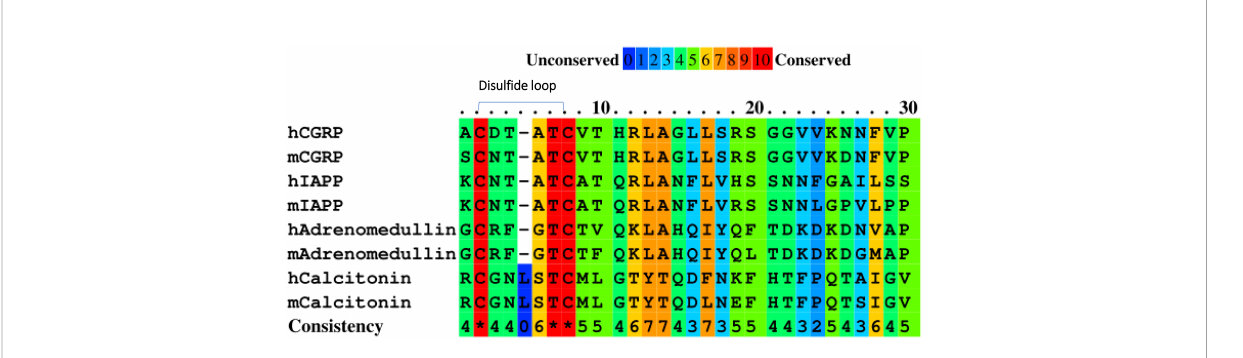
FIGURE 1 Amino acid sequence alignment of the CGRP family proteins in humans (h) and mice (m) using